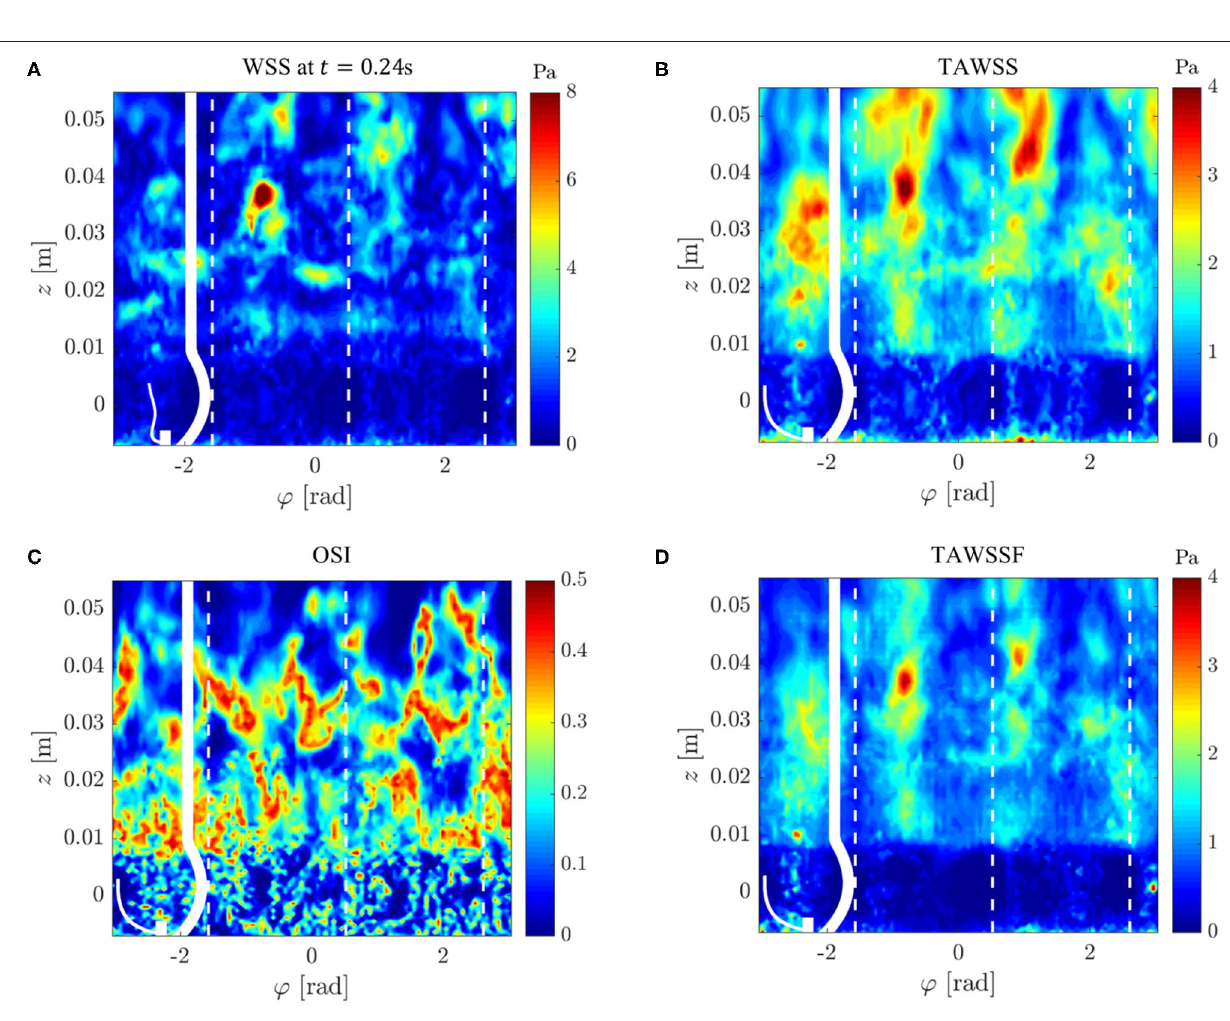
Frontiers in Physiology |